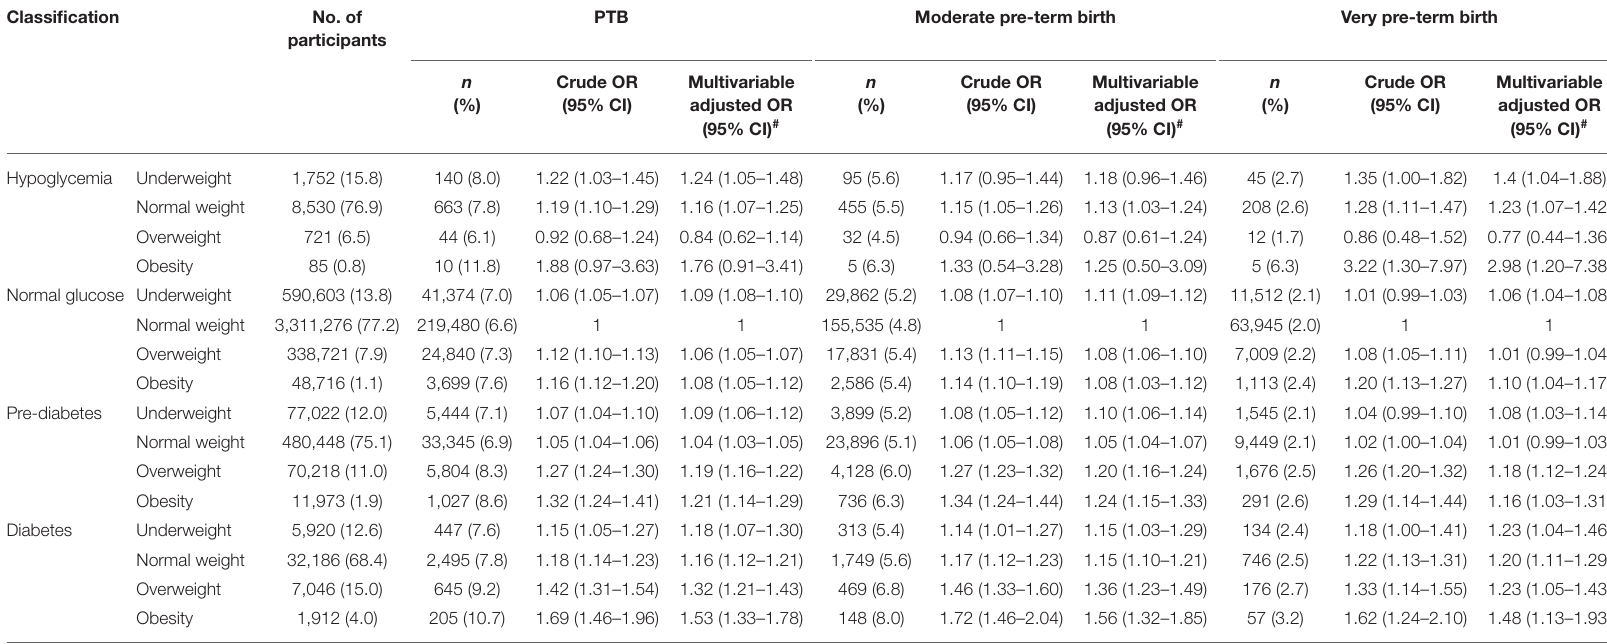
BMI, body mass index; FPG, fasting plasma glucose; PTB, pre-term birth (28 to < 37 weeks); MPTB, moderate pre-term birth (34 to < 37 weeks); VPTB, very pre-term birth (28 to < 34 weeks); OR, odd ratio. Multivariable-adjusted OR (95% CI) were adjusted for characteristics of women (age, education, ethnic, occupation), parity, smoking and alcohol drinking before or during early pregnancy, history of adverse pregnancy outcomes, history of hypertension, thyroid dysfunction, anemia, infectious disease, and sex of